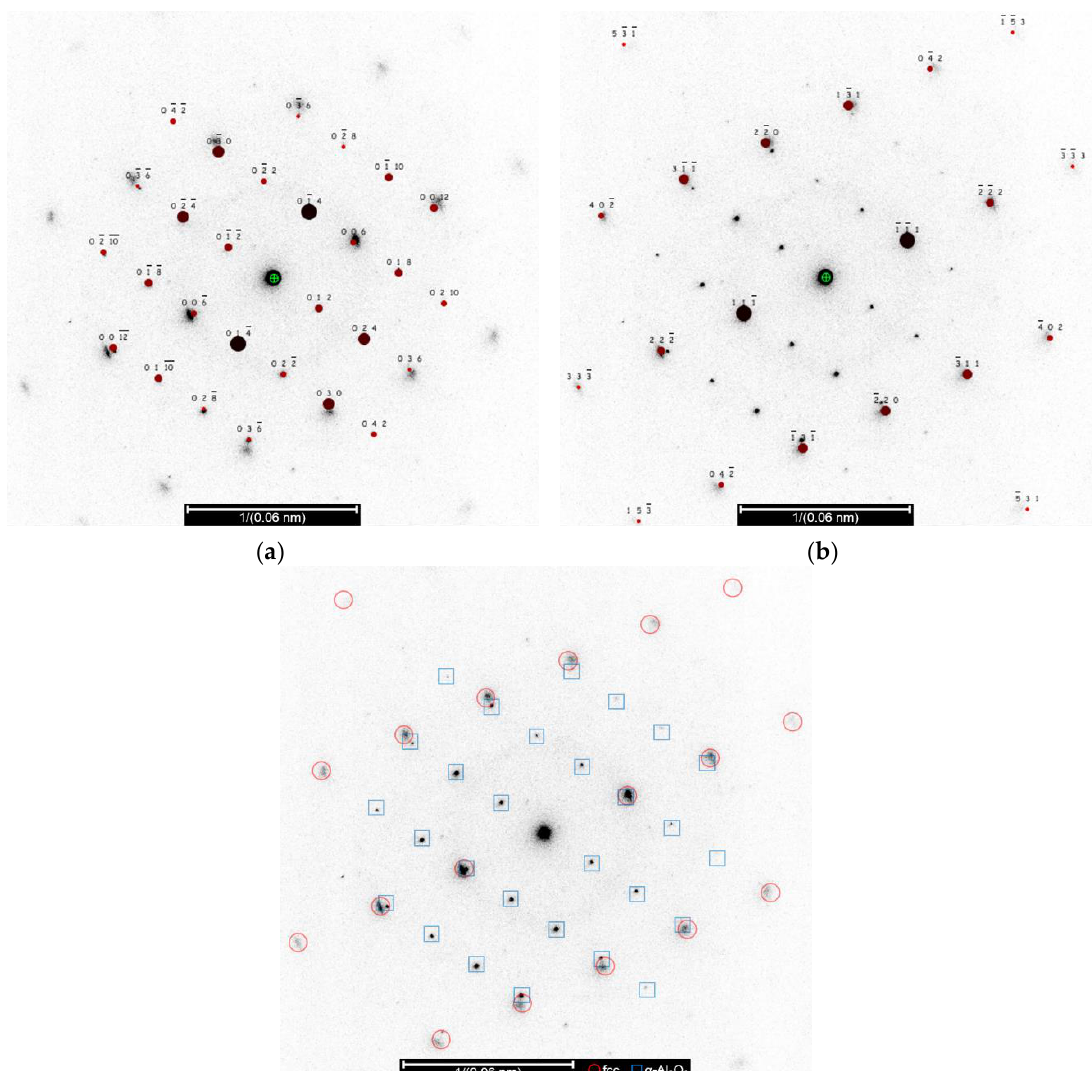
Figure 4. Indexed diffraction pattern of ( a ) α-Al 2 O 3 substrate (zone axis [21̅1̅0] ); ( b ) fcc Cu/Fe 0.58 Mn 0.42 layer (zone axis [112] ); ( c ) Diffraction pattern of the layer system α-Al 2 O 3 /Cu/Fe 0.58 Mn 0.42 ( fcc and α-Al 2 O 3 diffraction spots are labelled with red circles and blue squares, respectively).